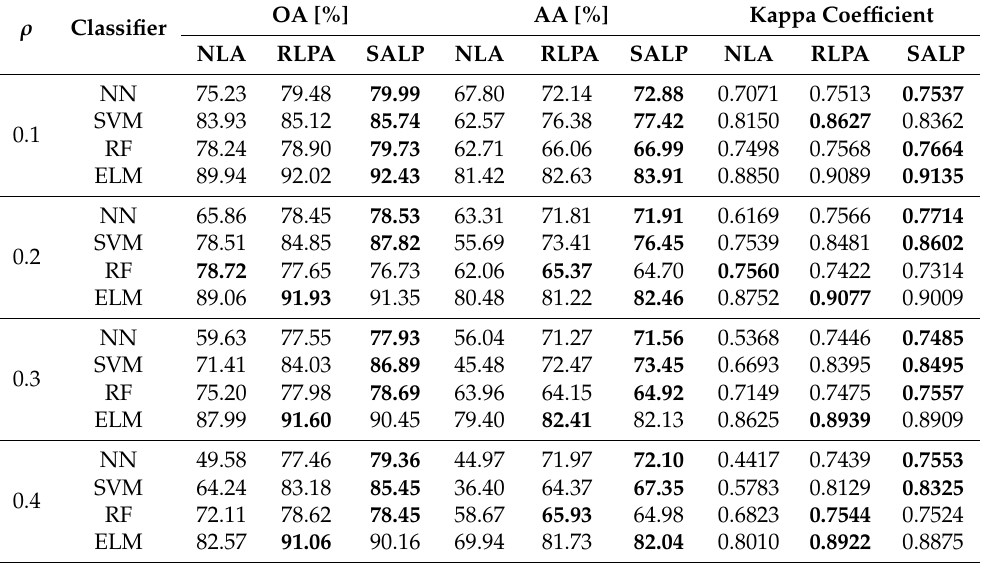
Table 3. Comparisons of baselines and SALP over four typical classifiers with the “both” Setting on the Indian Pines dataset. The best results are